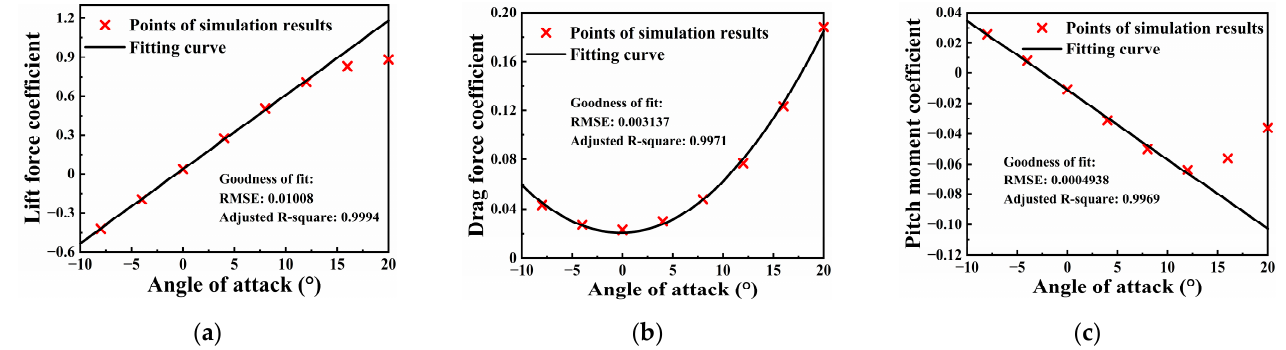
Figure 2. Curve fitting of aerodynamic coefficients versus the angle of attack: ( a ) lift force; ( b ) drag force; ( c ) pitch moment.